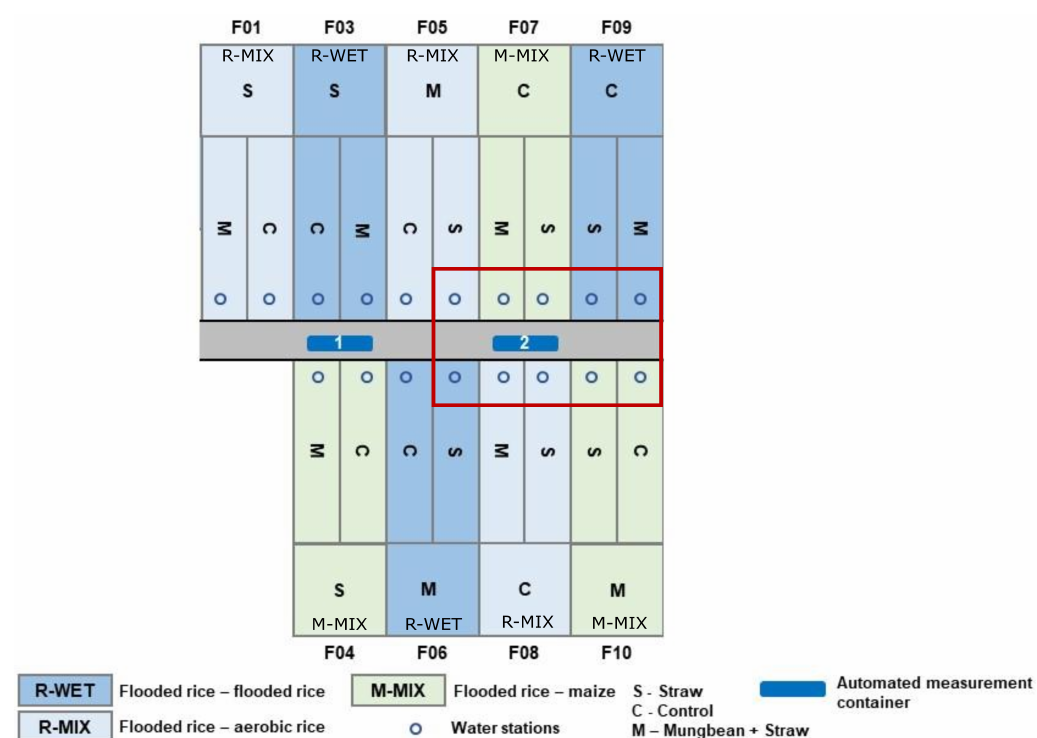
Figure 1. Experimental field design. The experiment consisted of nine fields (F) with three different water management practices (Field codes: R-WET, R-MIX, M-MIX). Each field was separated into three plots with different treatments (S = straw incorporated in the soil, M = straw plus mung bean as an inter-crop in the dry to wet transition period, C = control). Blue circles indicate water sampling stations. The automatic analytical system, installed in container 2 (blue rectangle), was connected to the 10 water sampling stations inside the red